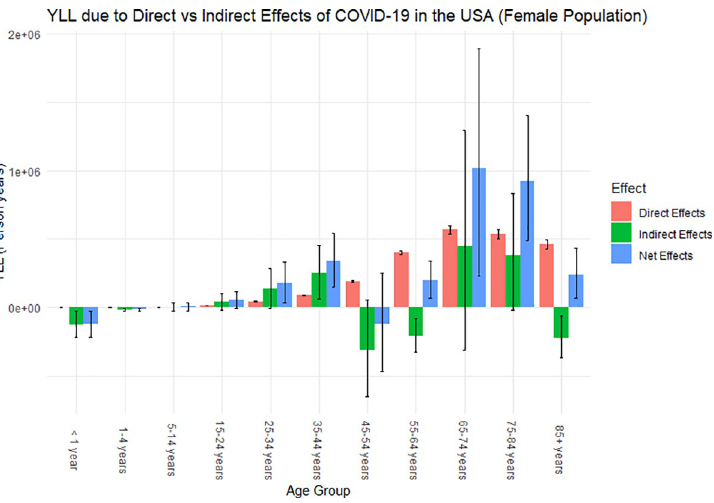
Fig 3. Years of life lost attributed to the overall effects of COVID-19 for the female population of the United States in 2020. Error bars are the uncertainty of how each effect impacted the YLL for each age group.